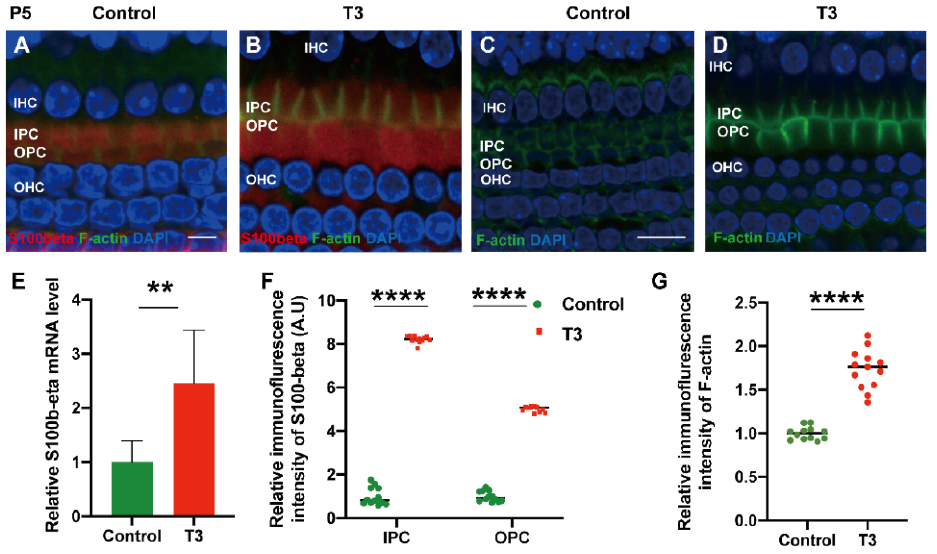
Figure 6. S100 β plays in the growth of PCs via acetylated α -tubulin. ( A , B ) Immunofluorescence staining of S100 β (red) and microfilaments (F-actin, green) in the cochlear basilar membrane of P5